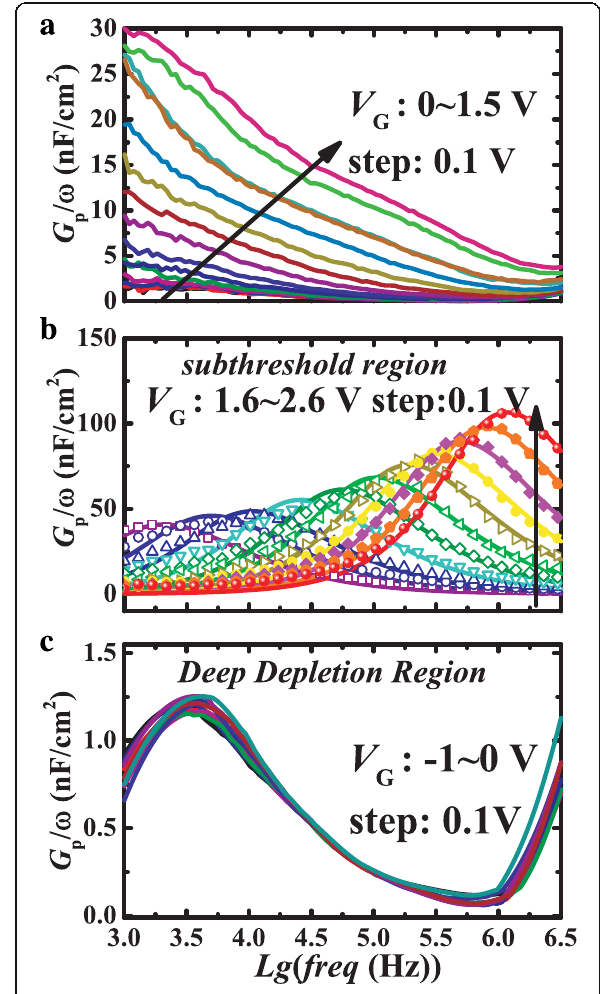
Fig. 3 Typical frequency-dependent parallel conductance ( a ) with 0 < V G < 1.5 V ( b ) with 1.5 V < V G < 2.6 V (subthreshold region) ( c ) with V dots are the experimental data G < 0 V (deep depletion region); the and the solid lines are fitting